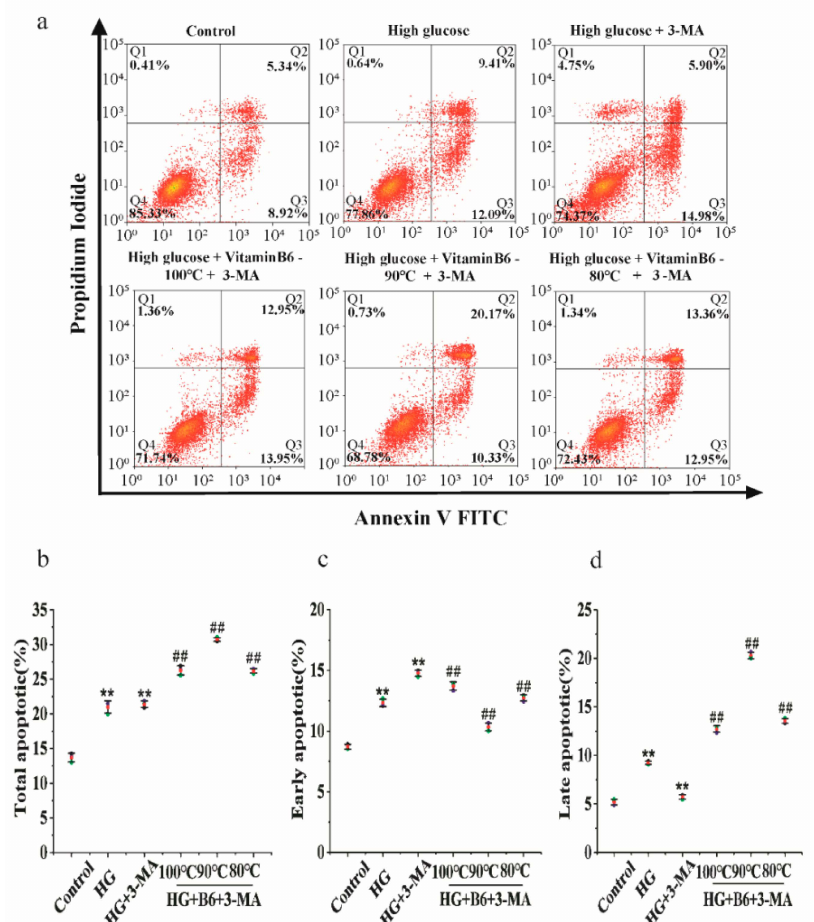
Figure 8. Hydrothermally processed vitamin B6 protected RIN-m5F cells from apoptosis by inducing autophagy under high glucose stress. ( a ) RIN-m5F cells were cultured with or without 20 mM glucose plus 10 mM 3-MA or with 20 mM glucose plus 20 µ M hydrothermally processed vitamin B6, or 20 mM glucose plus 10 mM 3-MA plus 20 µ M hydrothermally processed vitamin B6, and the apoptosis rate was measured by flow cytometry. ( b – d ) Cells were treated as described in ( a ), and apoptosis rates were analyzed (Error bars, SD ** p < 0.01 indicates significant differences compared with the control group by one-way ANOVA. ## p < 0.01 indicates significant differences compared with the control group by one-way